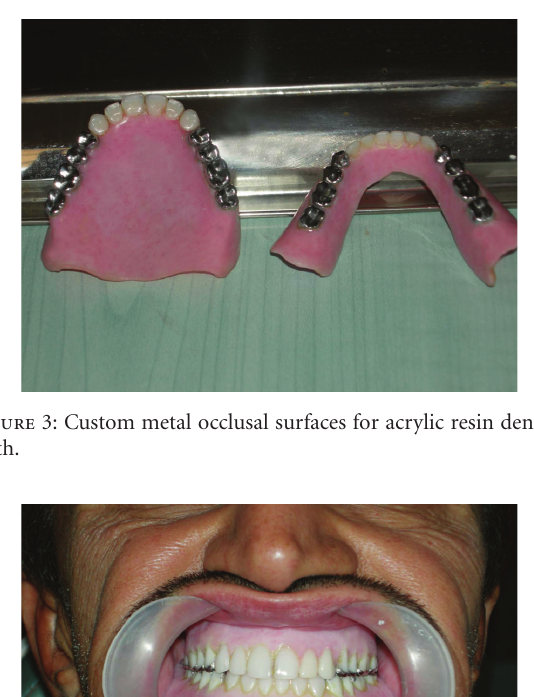
Figure 5: Postoperative extraoral